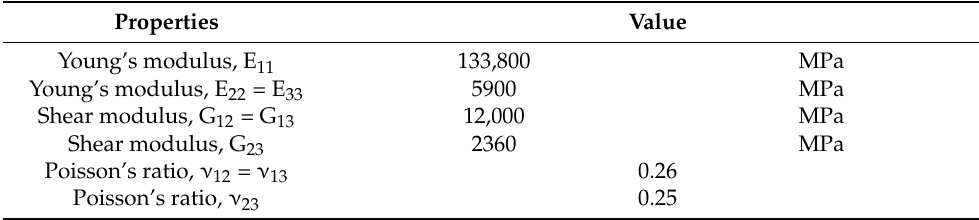
Table 1. Mechanical properties of the adopted prepreg in cured state.